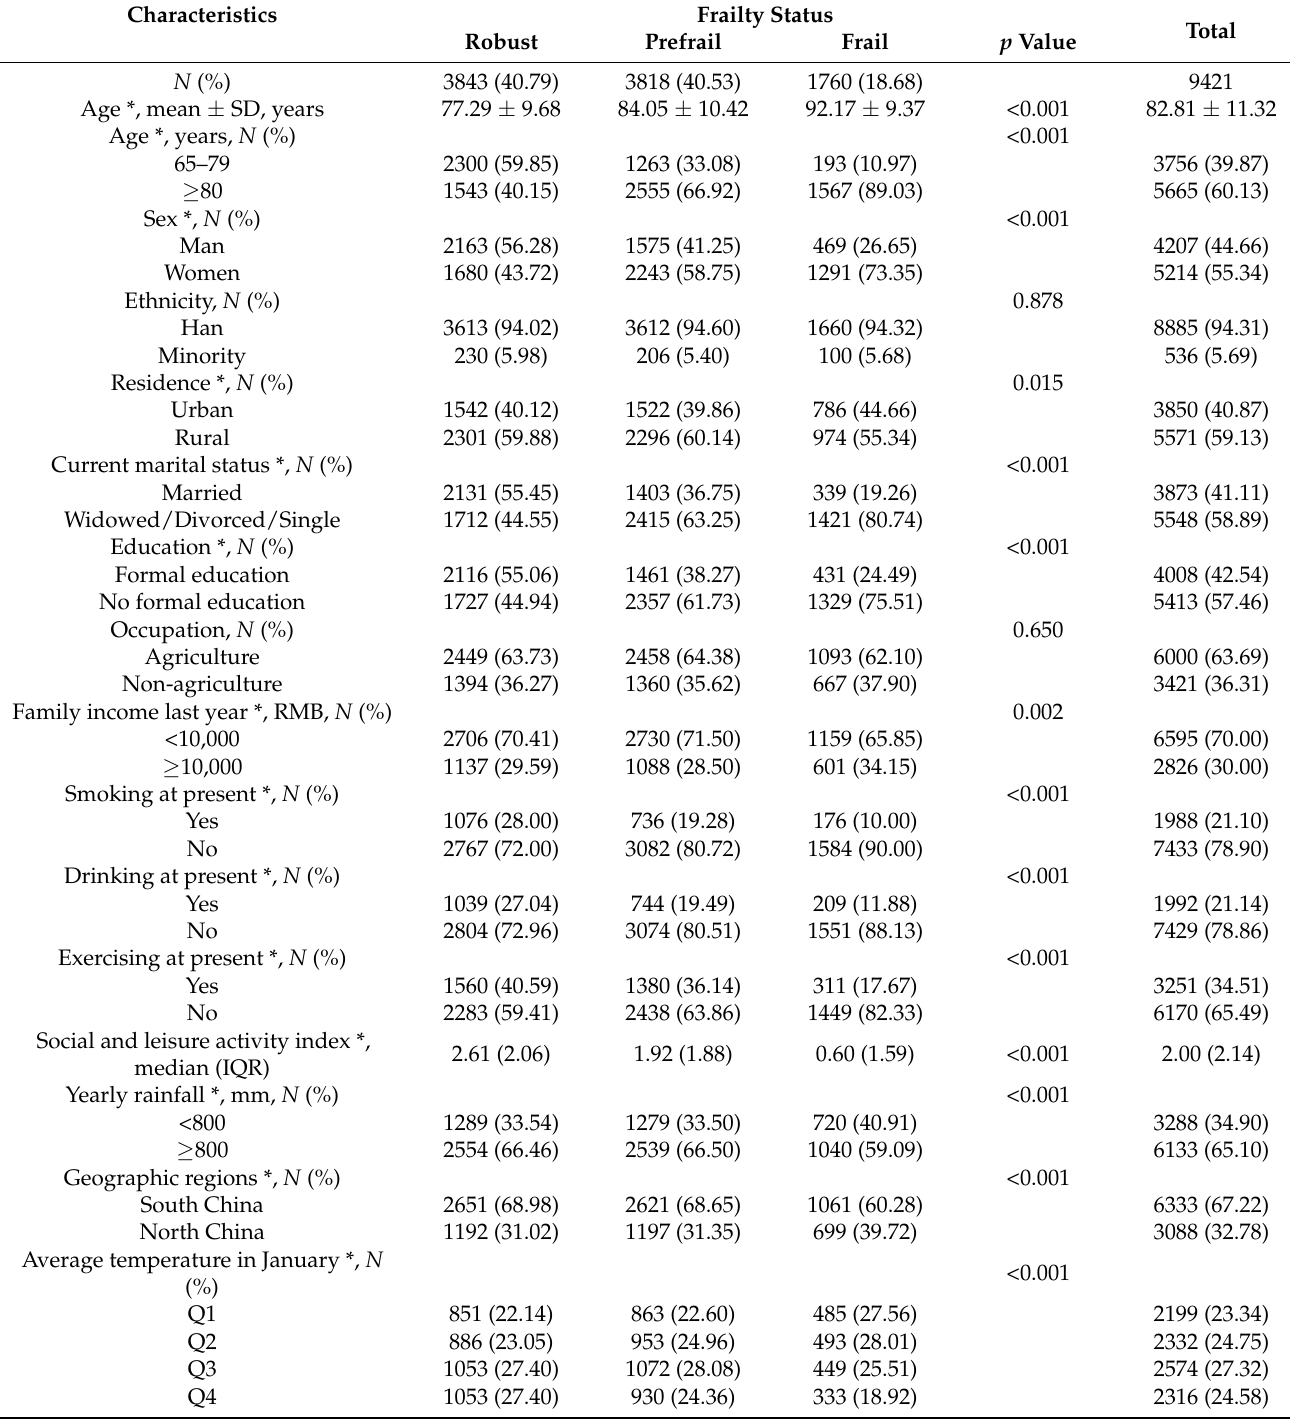
Table 1. Characteristics of the study participants in the Chinese Longitudinal Healthy Longevity Survey